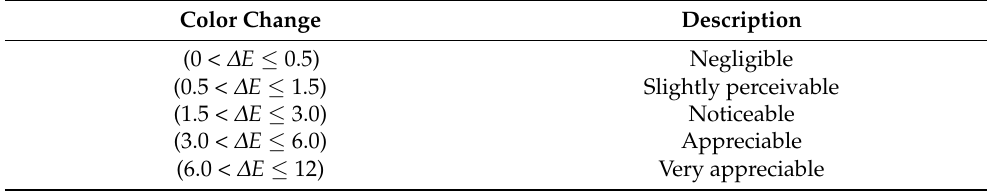
Table 3. Classification of color change ( ∆ E ).